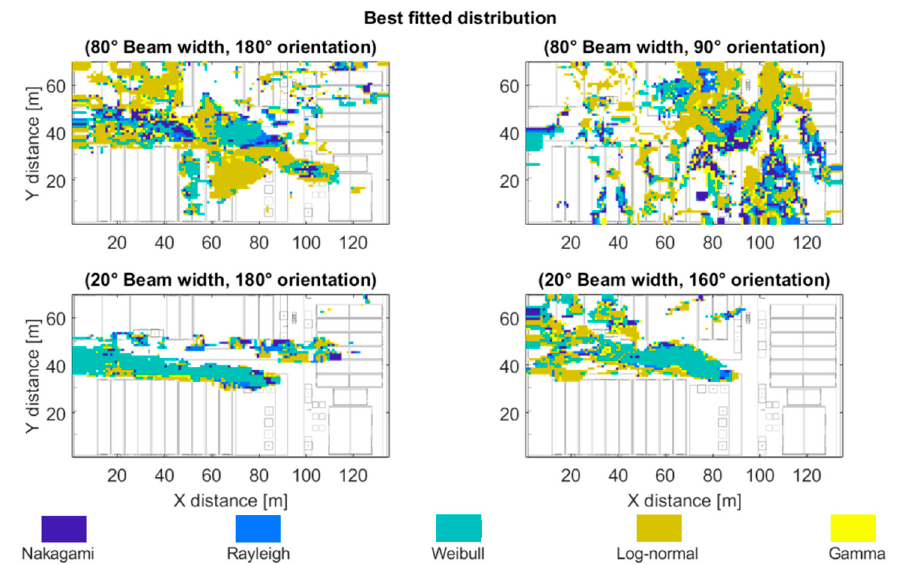
Figure 11. Best fitted distribution for the outdoor scenario (at 28 GHz, beam width values of 80° and 20°, with 180° and 90° orientation) at the bi-dimensional plane of 1.3 m height.